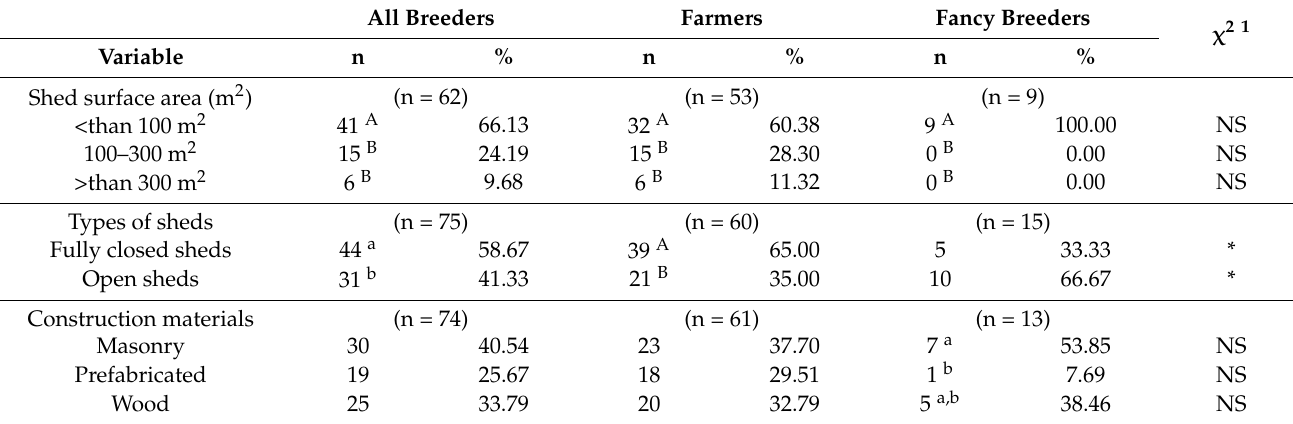
Table 6. Chicken shed design: responses from all breeders and divided according to breeder category. All Breeders Farmers Fancy Breeders